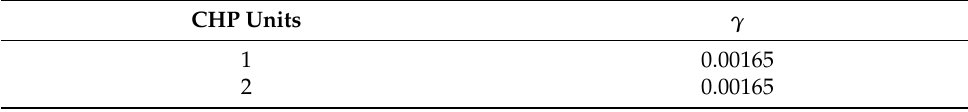
Table A5. Emission coefficients of the heat-only units.